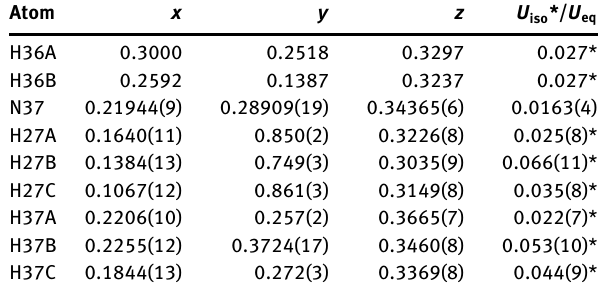
Table 2: Fractional atomic coordinates and isotropic or equivalent isotropic displacement parameters (Å 2